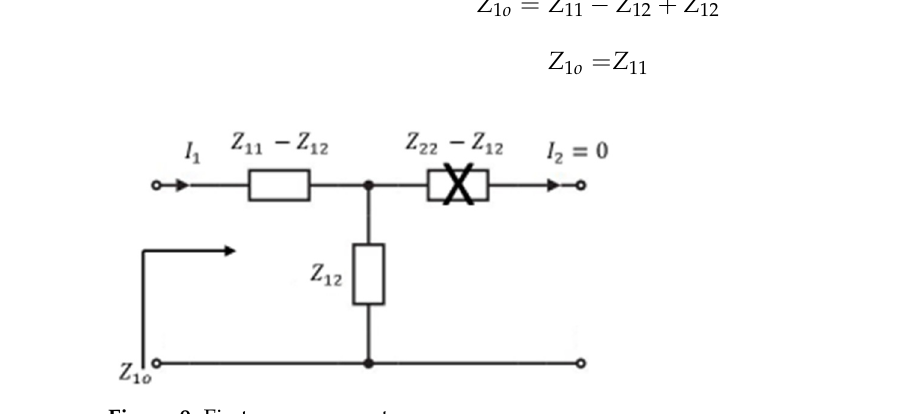
Figure 9. First measurement.